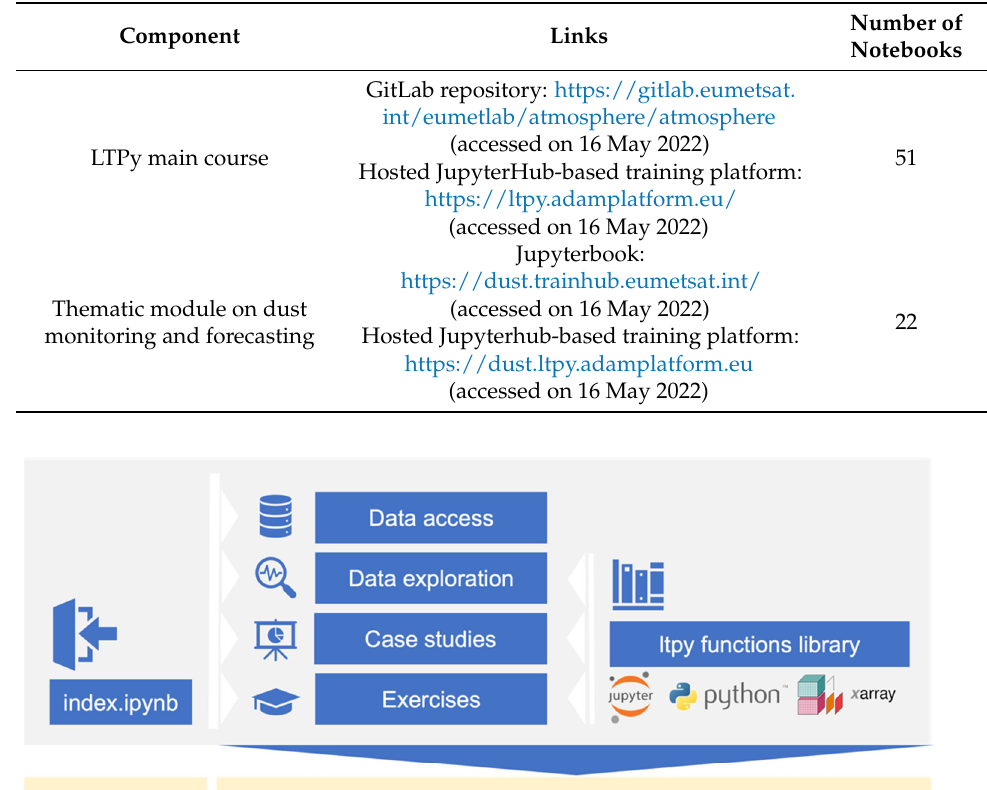
Table 1. Overview of the Learning Tool for Python components.